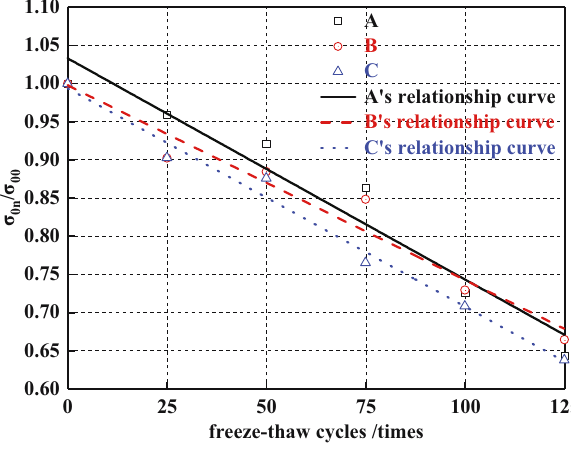
n 0 Relationship with the number of freeze – thaw Figure 14: σ σ 00